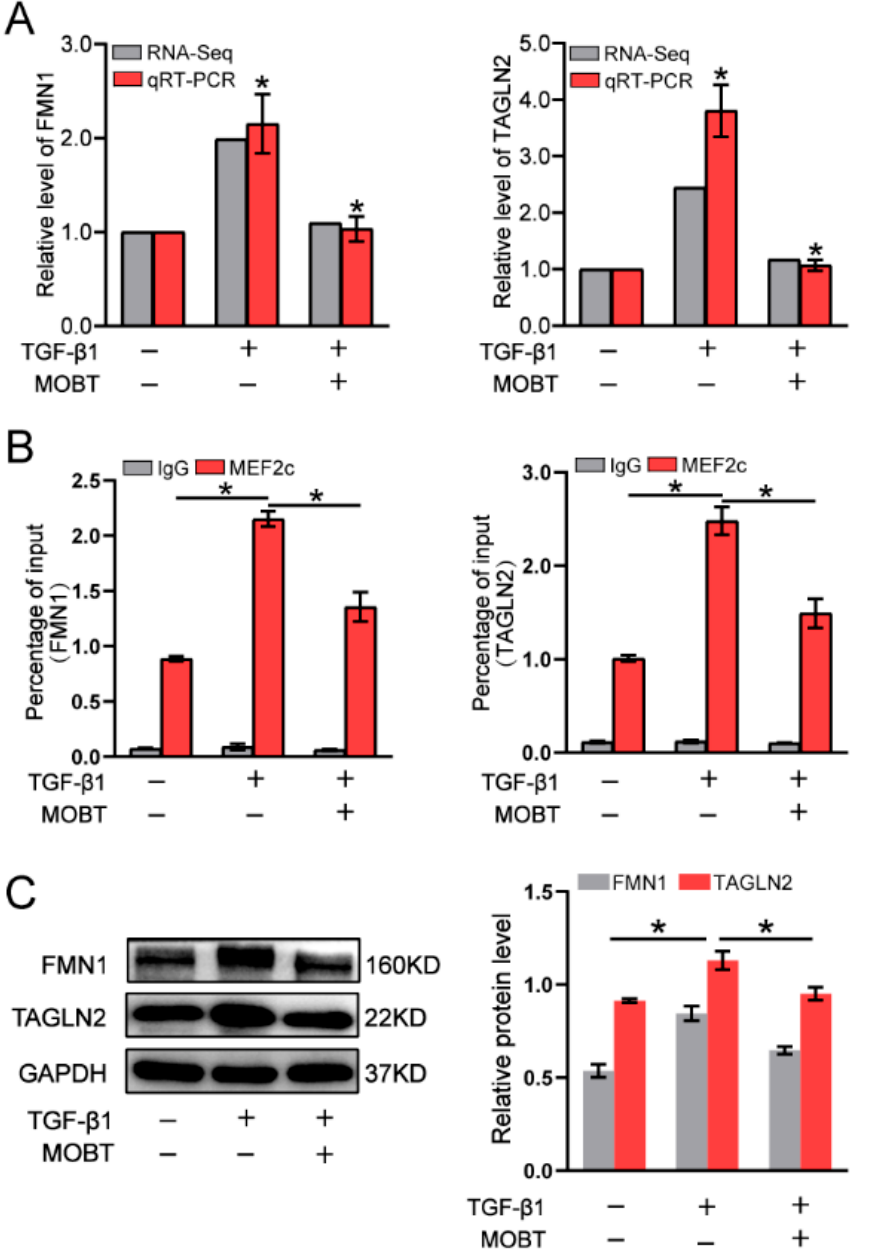
Figure 7. MOBT regulated TAGLN2 and FMN1 via MEF2c. ( A ) The qRT-PCR and RNA-seq data demonstrated that TAGLN2 and FMN1 decreased under MOBT treatment compared with those in the TGF- β 1 group. ( B ) The RIP experiment demonstrated that MEF2c bound to TAGLN2 and FMN1. ( C ) The Western blot result verified that MOBT inhibited TAGLN2 and FMN1. Each bar represents mean ± SD, * p < 0.05.